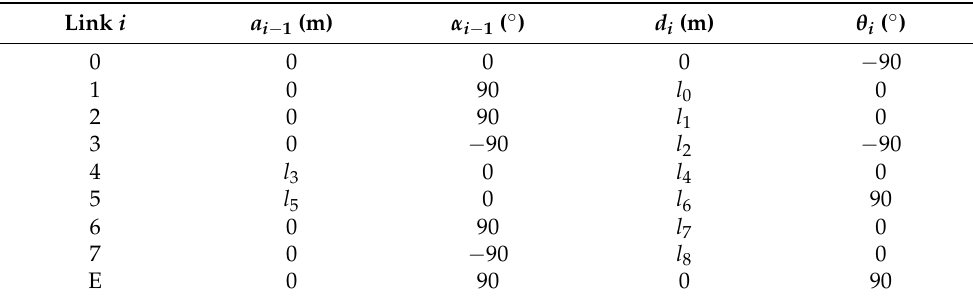
Table 2. The parameter list of the kinematic